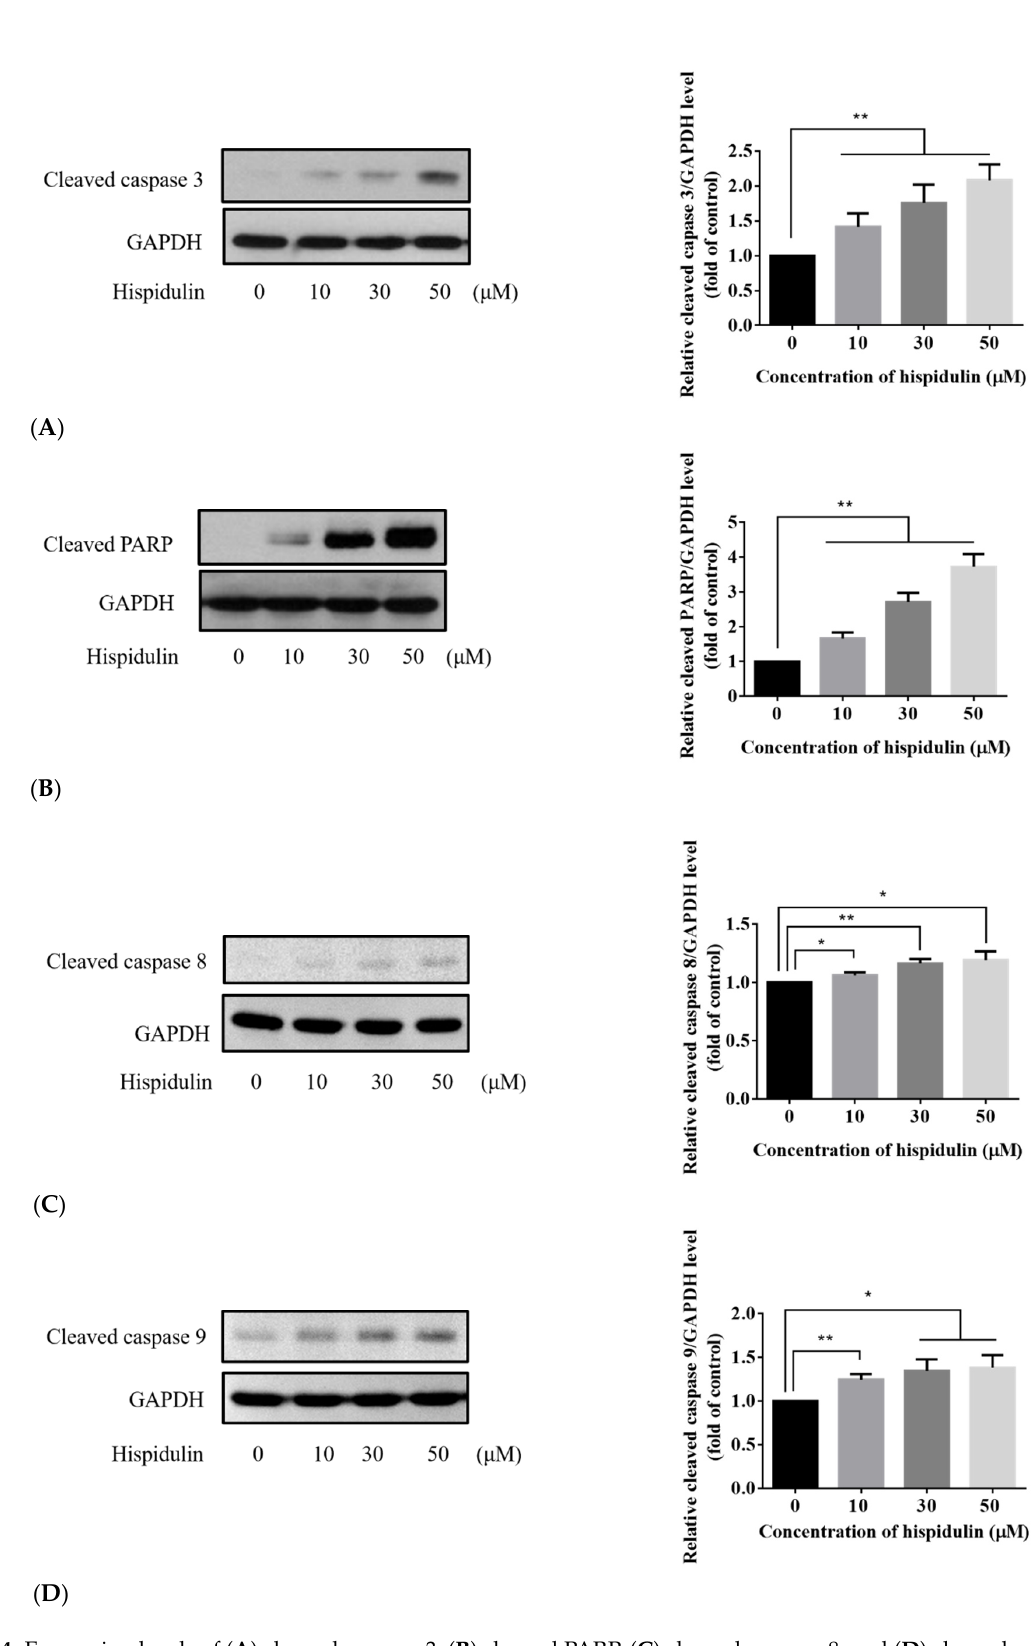
Figure 4. Expression levels of ( A ) cleaved caspase 3, ( B ) cleaved PARP, ( C ) cleaved caspase 8, and ( D ) cleaved caspase 9 in A2058 cells treated with indicated concentration of hispidulin or DMSO (control) for 24 h were examined by Western blot assay. GAPDH was used as an internal control. Data are presented as fold of control and mean ± SE, with * p < 0.05 and ** p < 0.01 compared with the control group (n = 5).